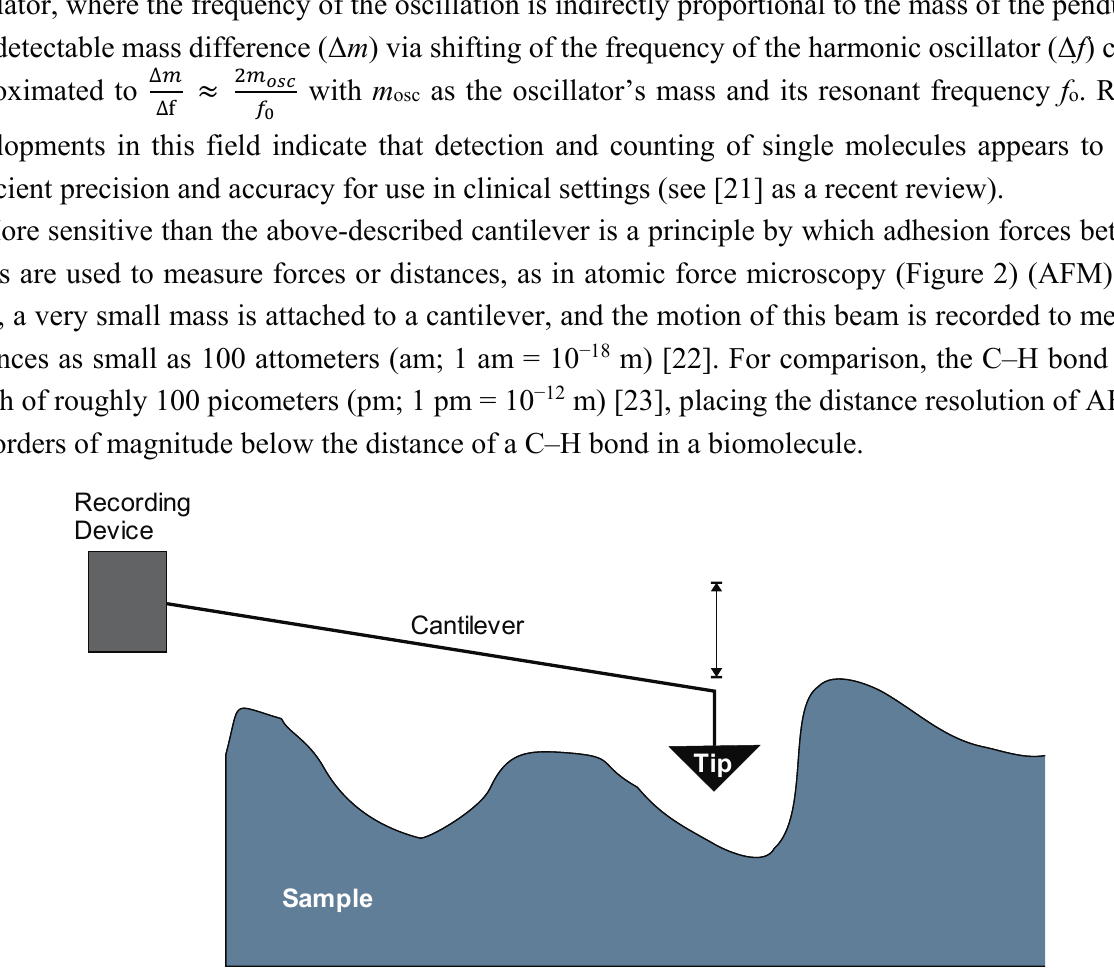
Figure 2. Schematic illustration of the principle of atomic force microscopy. In atomic